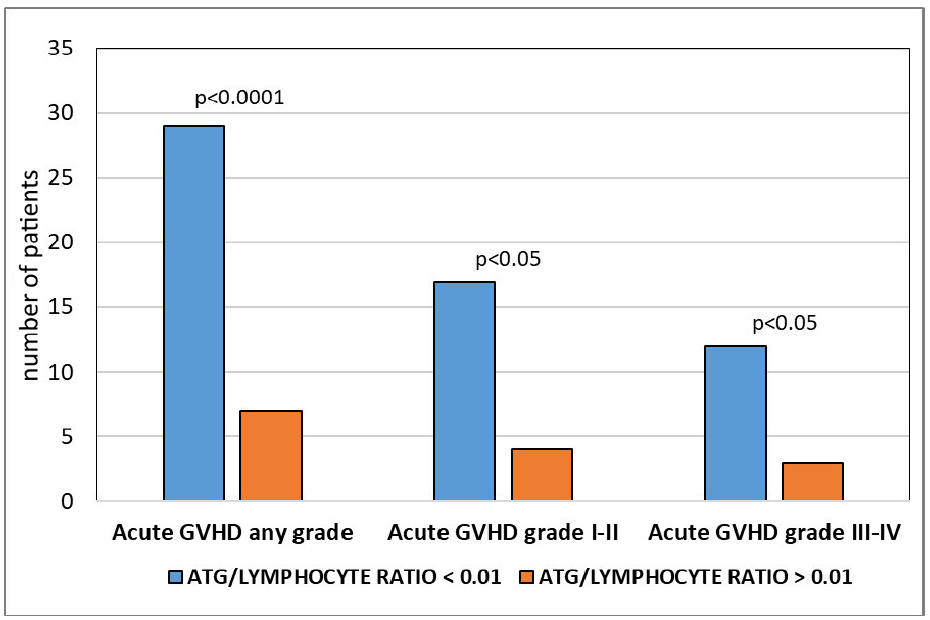
Figure 1. Cumulative incidence and incidence sorted by grades of acute GVHD in the low ATG/lymphocyte ratio group (blue columns) and high ATG/lymphocyte ratio group (orange columns).